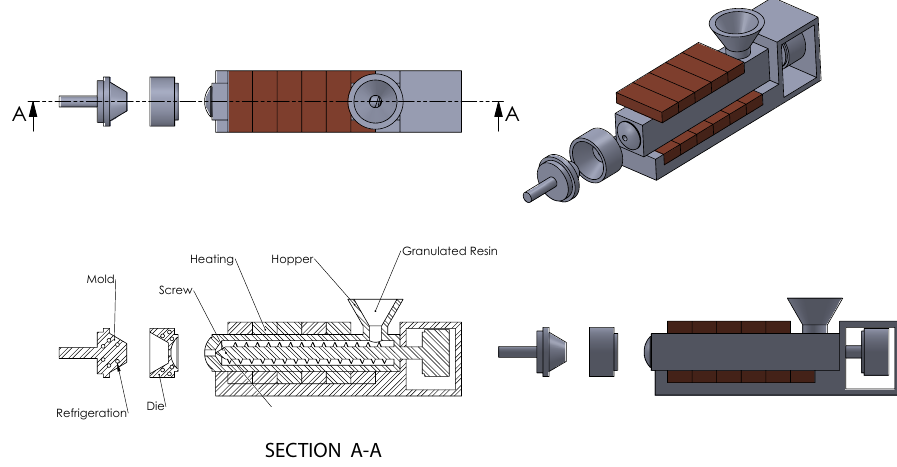
Figure 1. Schematic cutting of the die-nozzle composite